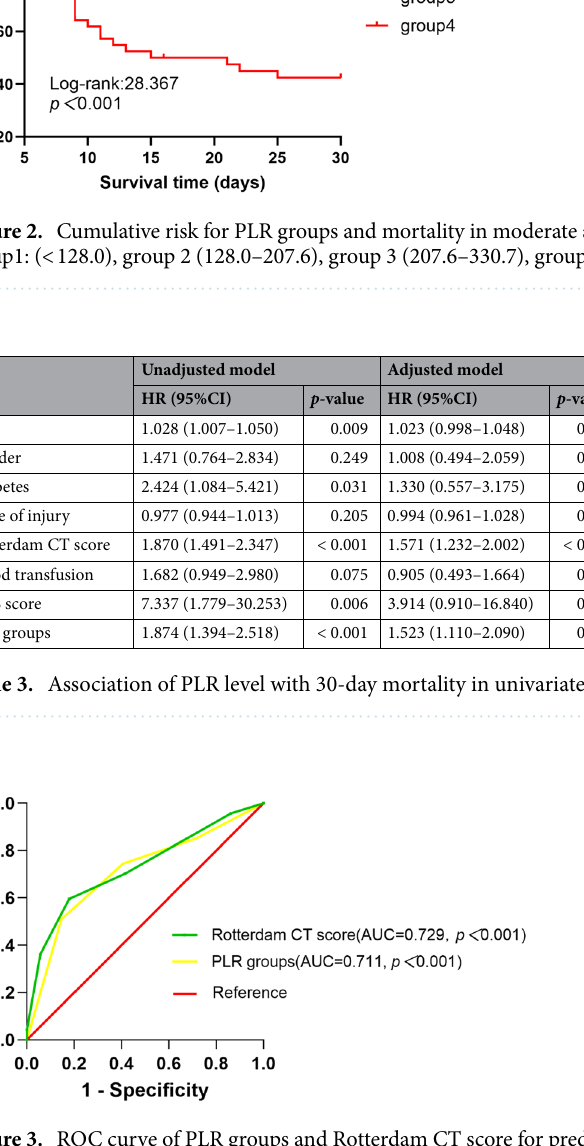
Figure 3. ROC curve of PLR groups and Rotterdam CT score for predicting short-term mortality in moderate to severe TBI